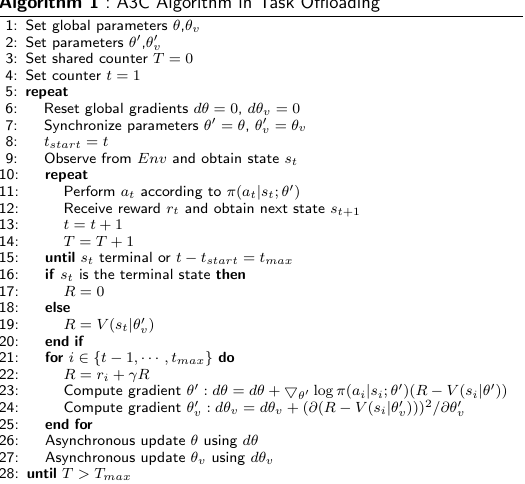
Algorithm 1 : A3C Algorithm in Task Offloading 1: Set global parameters θ , θ